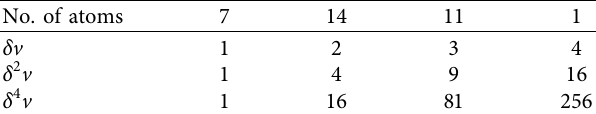
Table 4: Links dataset of the graph structure of